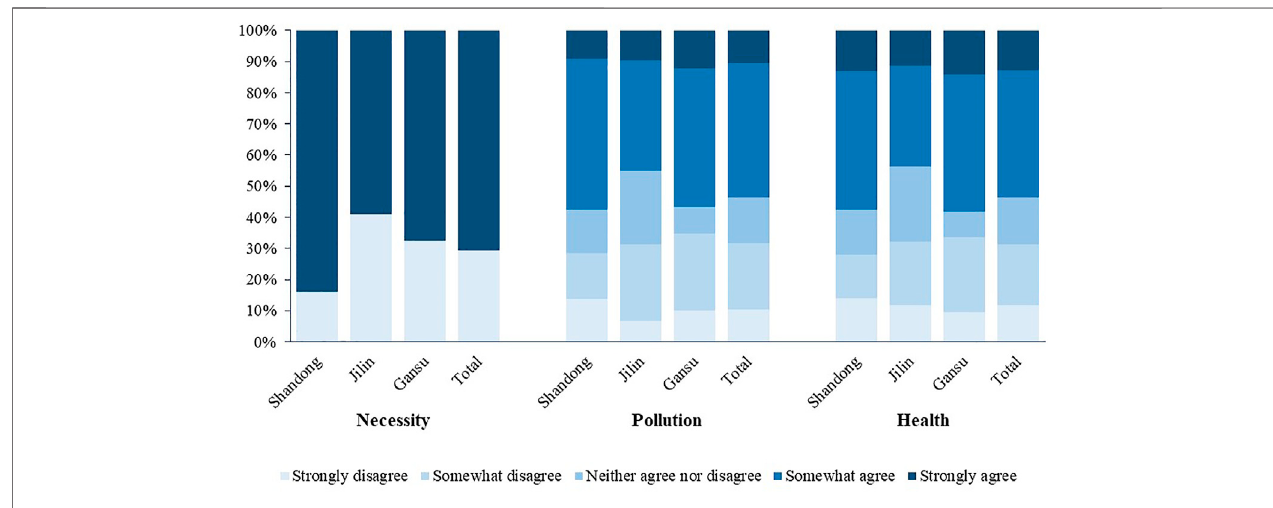
FIGURE 3 | Distribution of the farmers ’